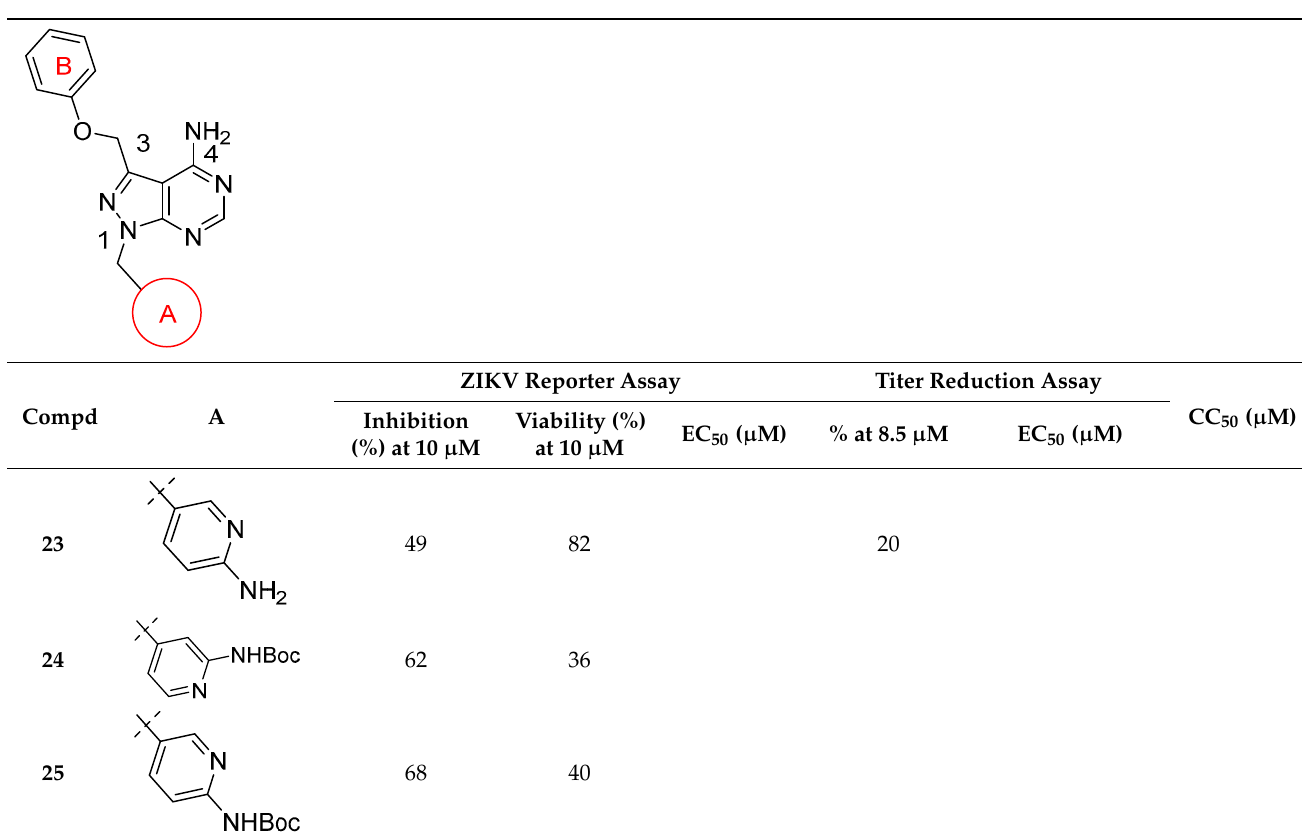
Table 2. Cont. Table 2. SAR study on ring A of 1 H ‐ pyrazolo[3,4 ‐ d]pyrimidin ‐ 4 ‐ amine